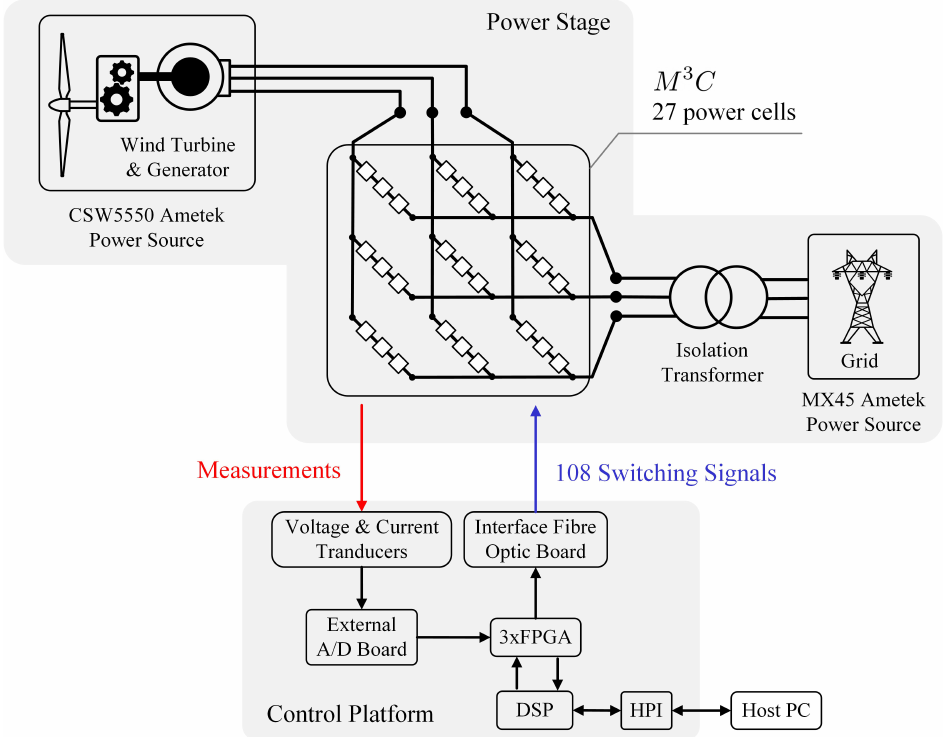
Figure 5. Diagram of an M 3 C experimental prototype. Adapted from